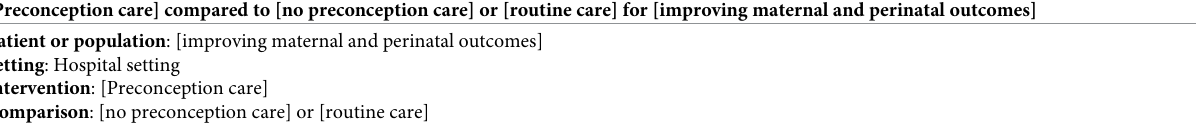
Table 6. Summary of findings